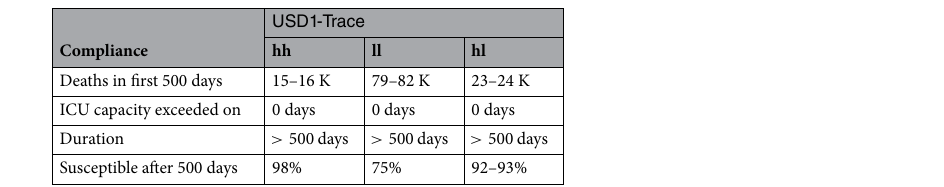
Table 9. Results for the uniform social distancing scenario USD1 with